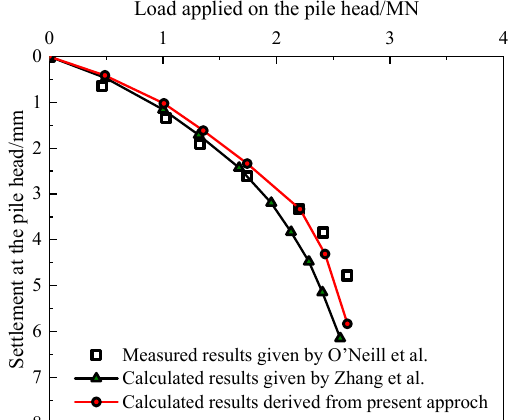
Figure 10. Comparison of the predicted and measured load–settlement curve for group piles